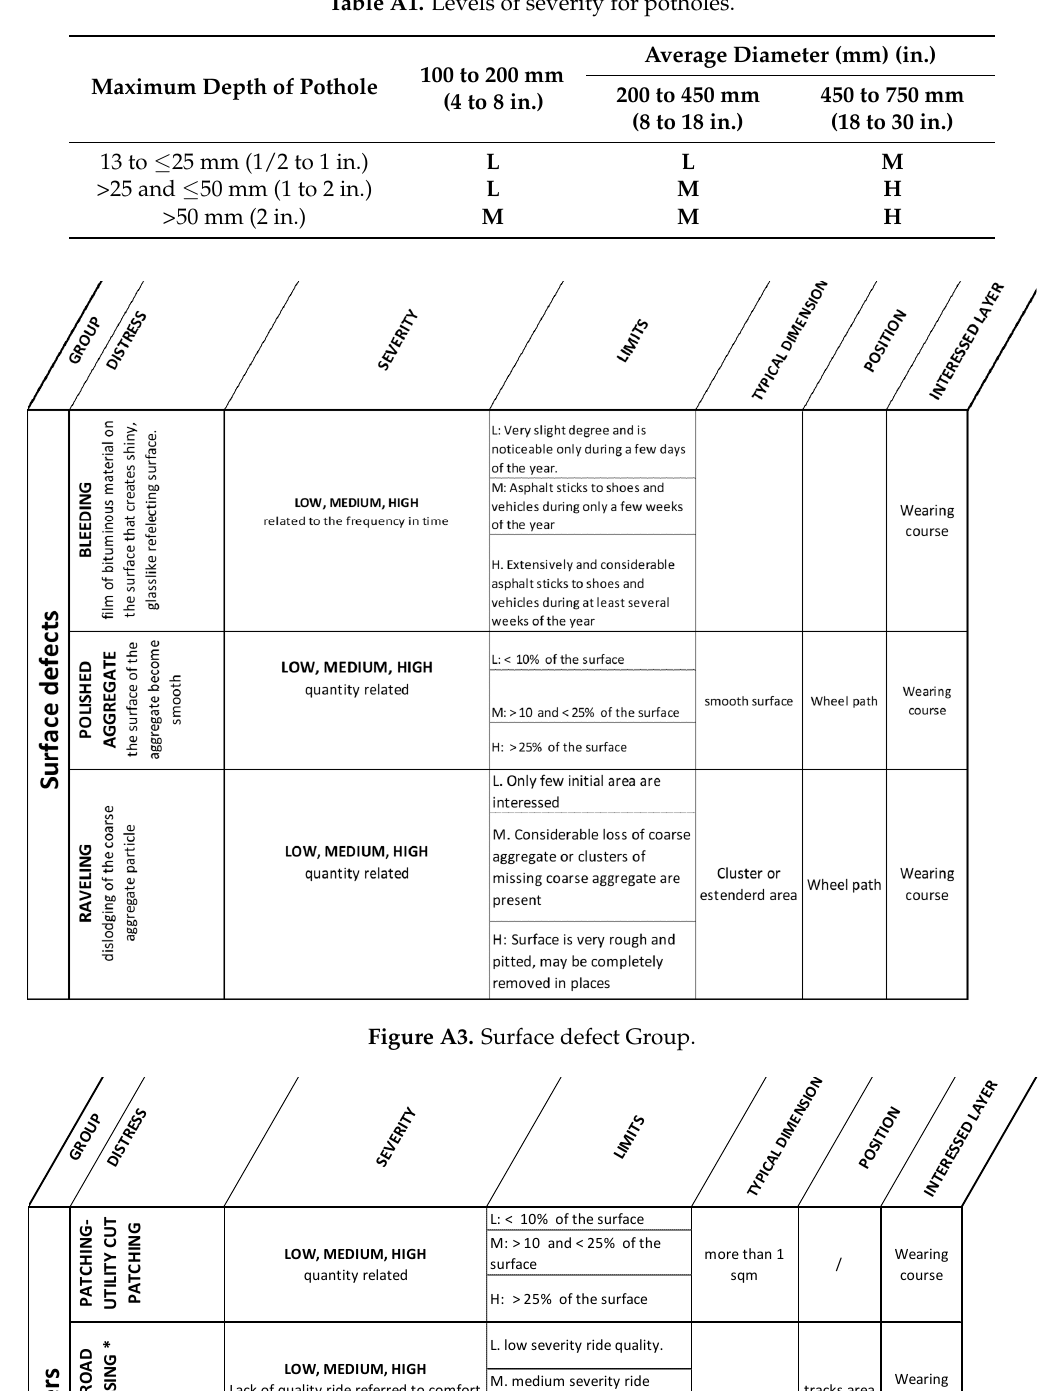
Table A1. Levels of severity for potholes.